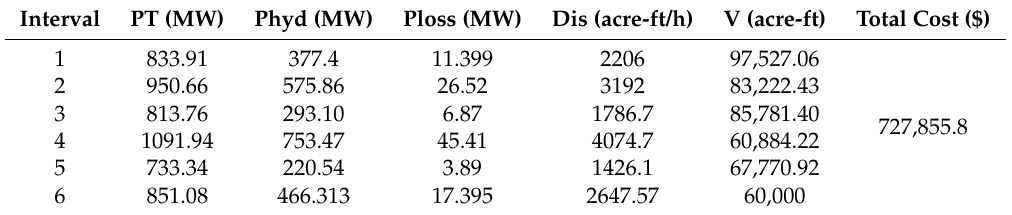
Table 8. Power flow and cost optimization with the improved APSO algorithm implementation.